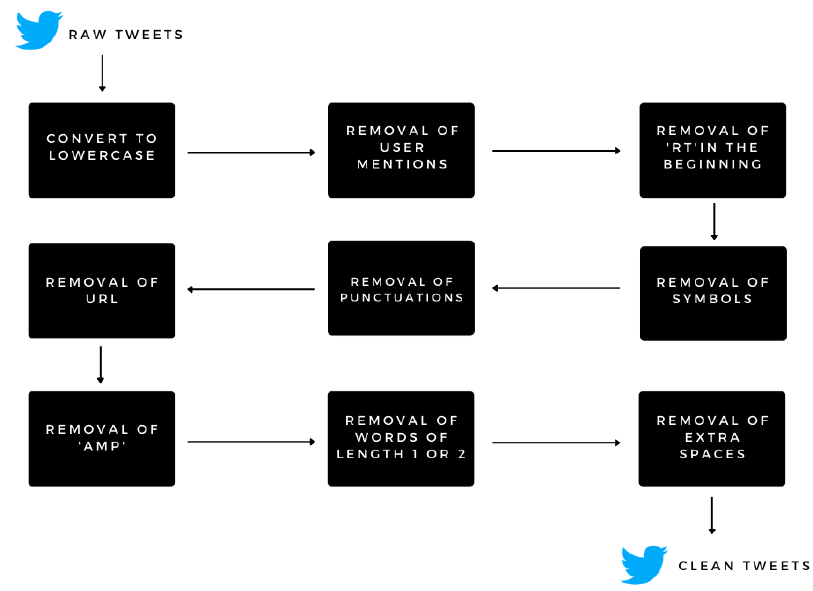
Figure 2. Data Figure 2. Data Preprocessing. Table 2. Calculated Data.